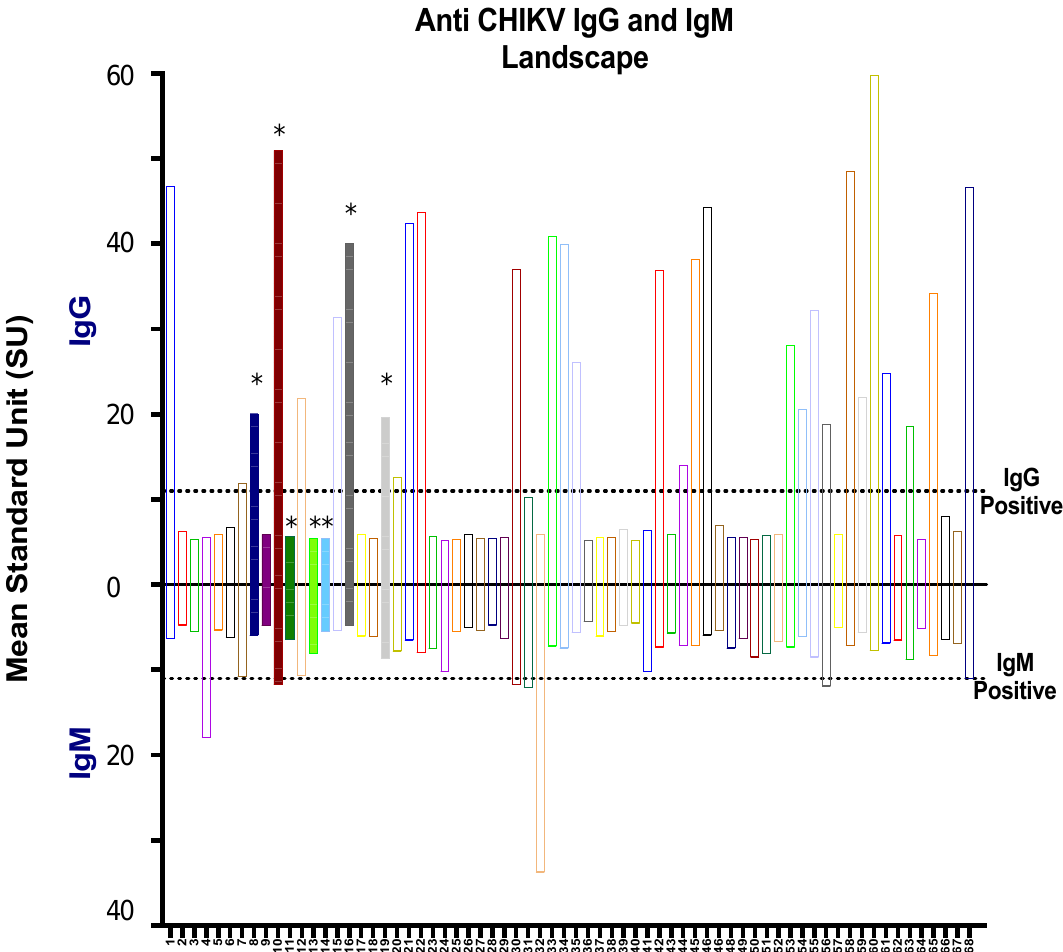
Figure 4. Qualitative ELISA assays using the commercial kits to assess the reactivity of human serum samples. Mean standard unit (SU) for IgG (positive y -axis) and IgM (negative y -axis) are represented for all 68 serum samples. Positive samples are defined as > 11 SU, and the negative samples are defined as < 9. The SU of samples 9–11 are defined as in the grey zone (inconclusive results). RT-PCR positive samples are indicated by the (*) and color-filled bars.